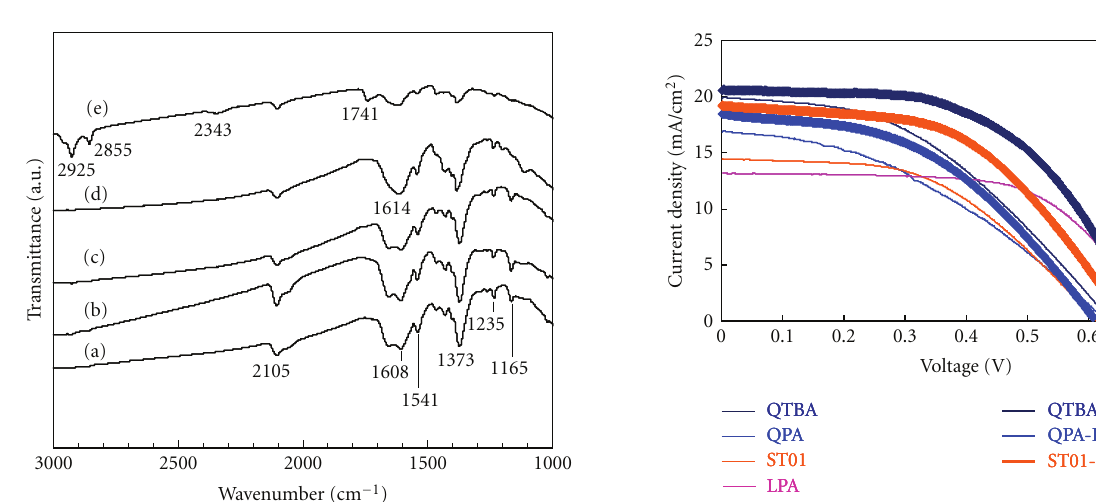
Figure 5: FT-IR spectra of the TiO 2 nanocrystals samples adsorbed by N719 dye. (a) N719-ST01; (b) N719-ST111; (c) N719-QTBA; (d) N719-QPA; (e) N719-LPA.